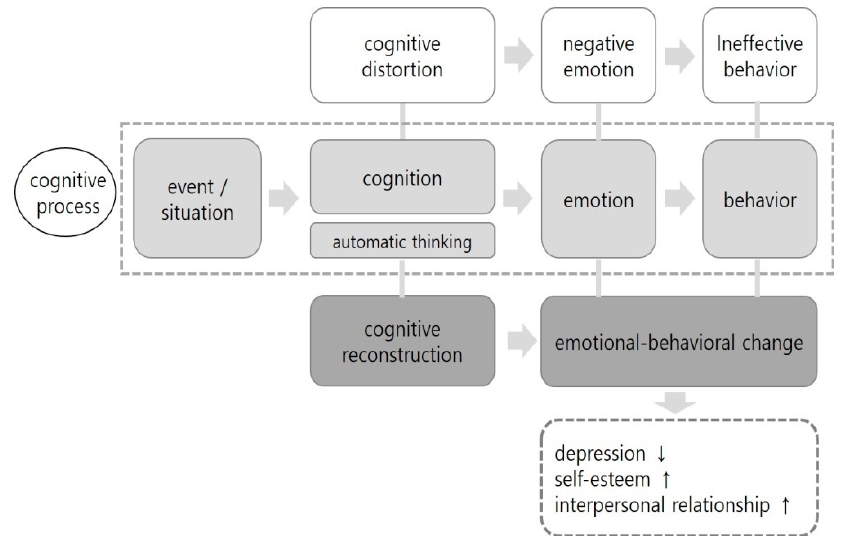
Figure 1. Conceptual framework of the cognitive behavioral group program .